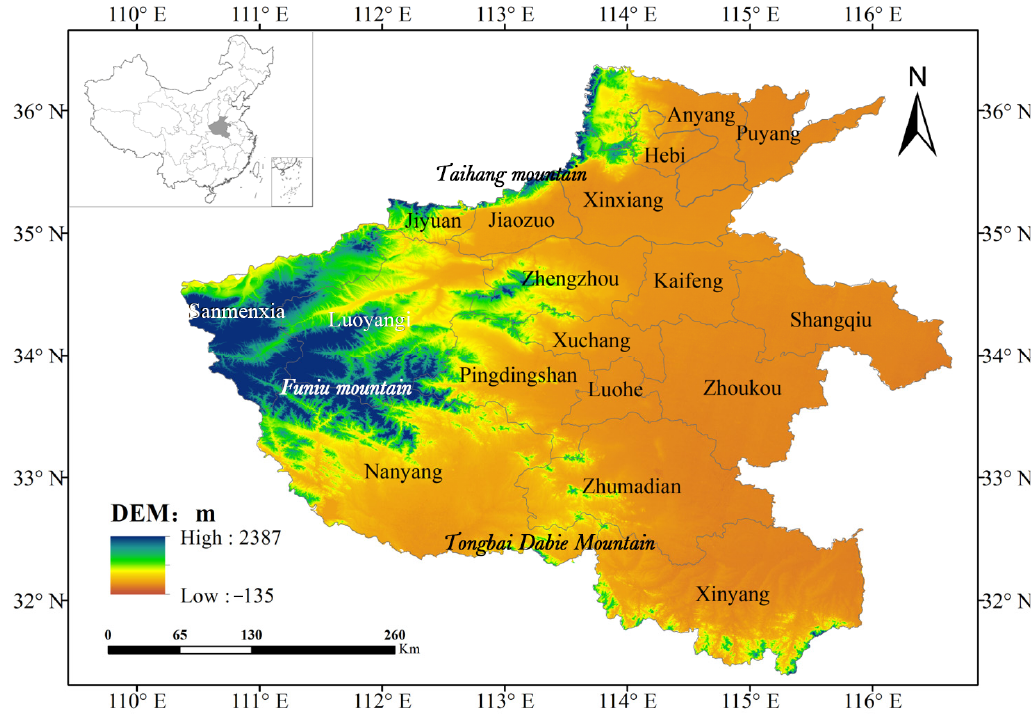
Figure 1. Topographical map of Henan Province.